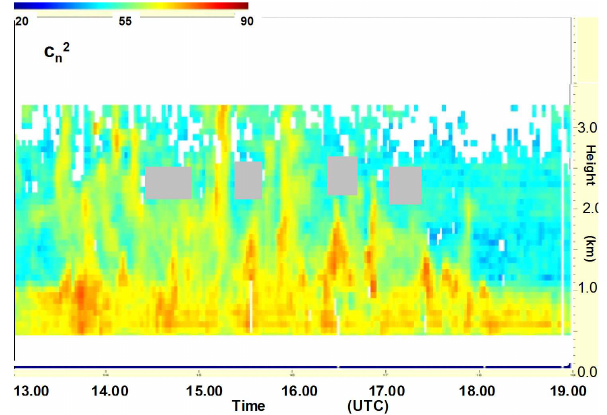
Fig. 13b. Wind U component measured by the wind profiler at Linkenholt 29 June 2005, 13:00 to 19:00UTC from 75 to 3250m a.g.l., doubtful measurements are greyed out.